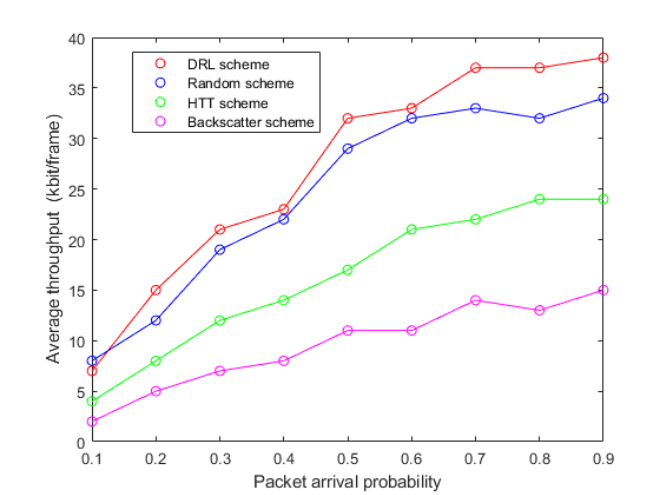
Figure 5. Average throughput of different schemes versus packet arrival